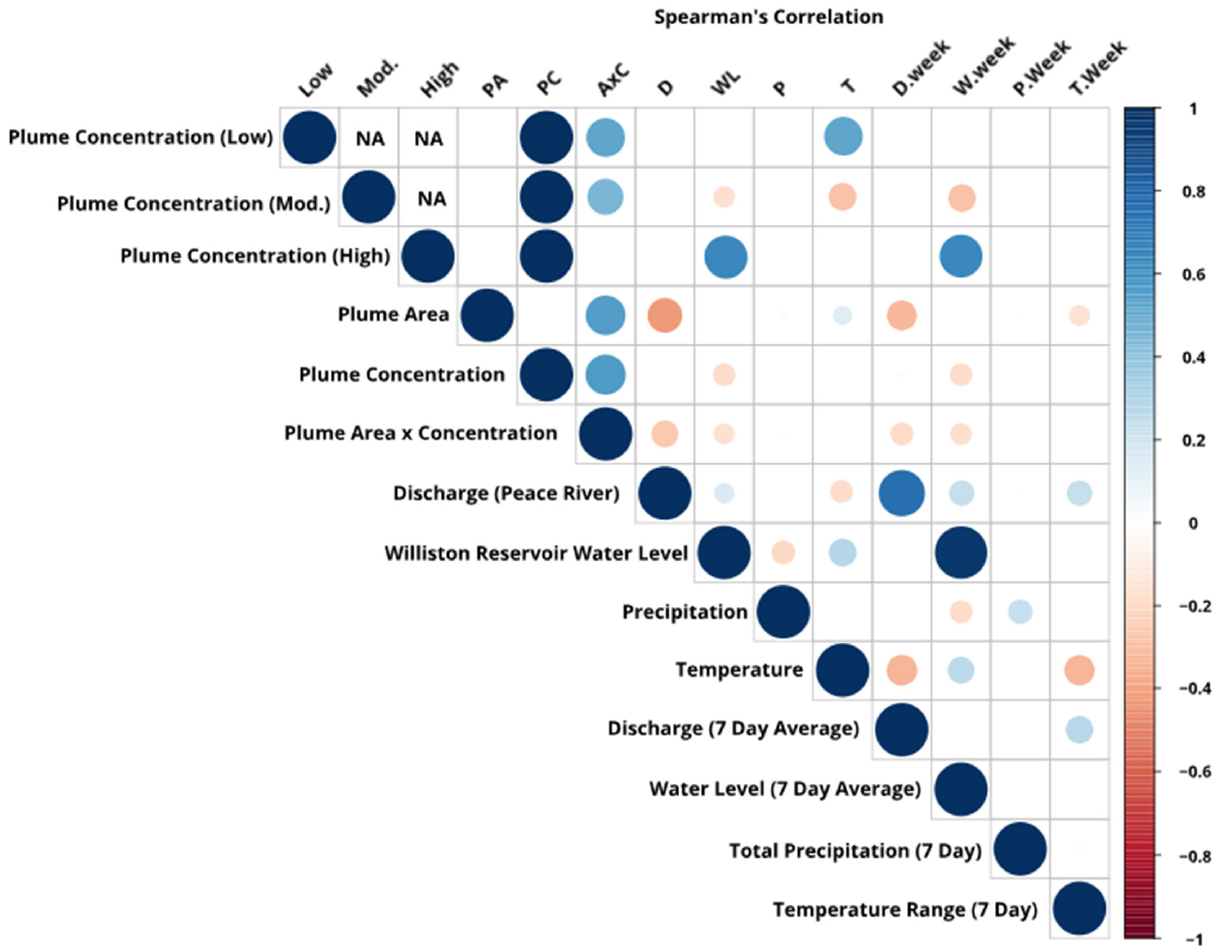
Figure 6. Correlation plot for hydro-meteorological variables and plume concentrations using Spearman’s correlation with a significance value of 0.1. The diameter of circles, as well as colour scale, indicate the strength of correlation.